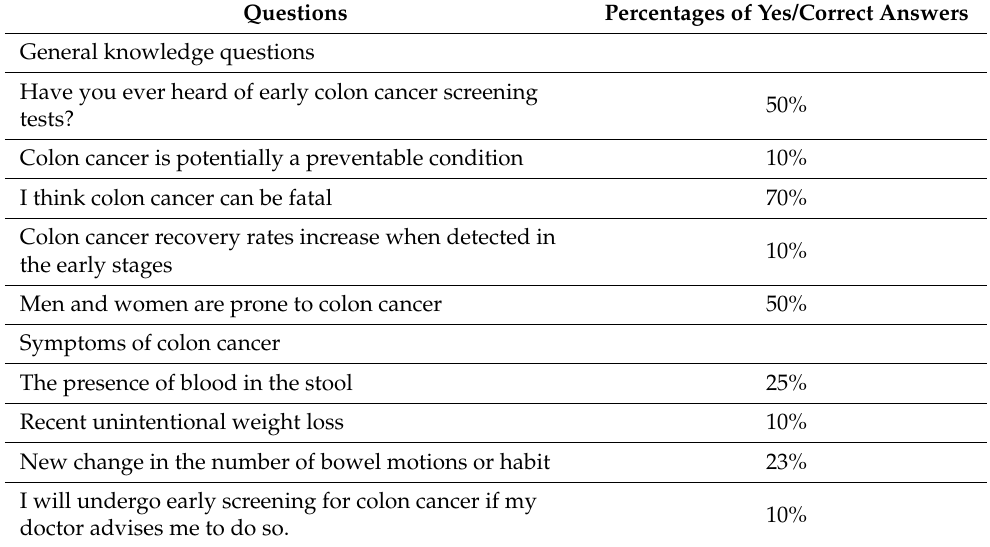
Table 2. Percentages of correct answers for public knowledge of colorectal cancer.